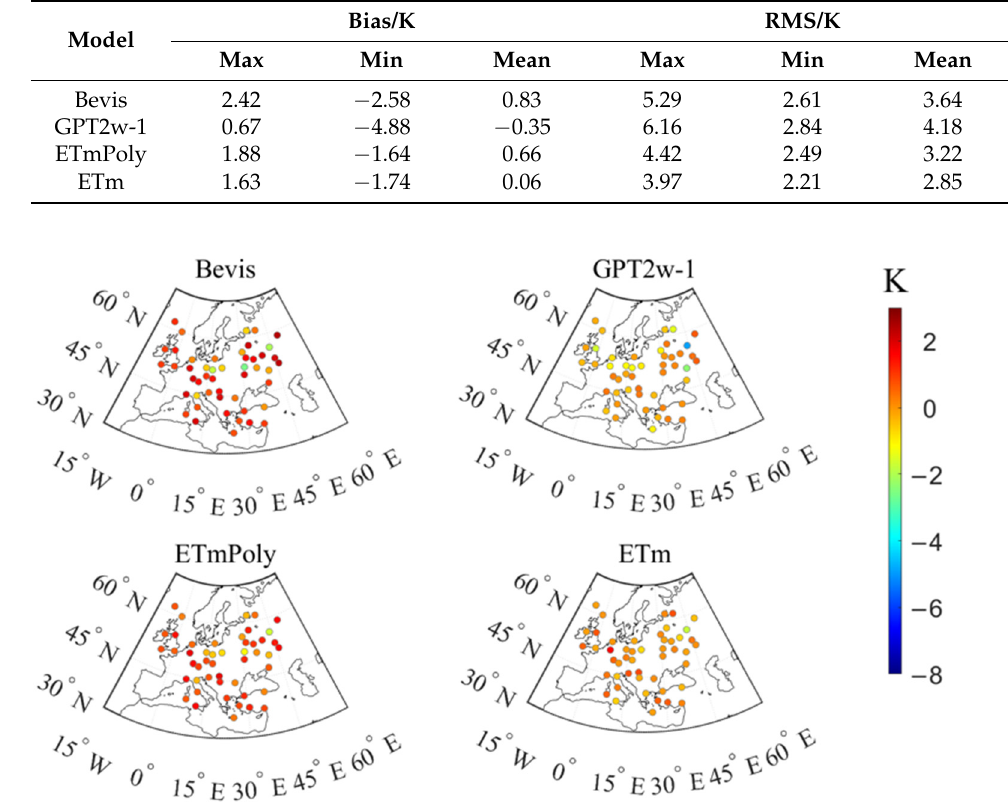
Table 2. Bias and RMS values of four Tm Models in 2021 using 48 modeling radiosonde stations.